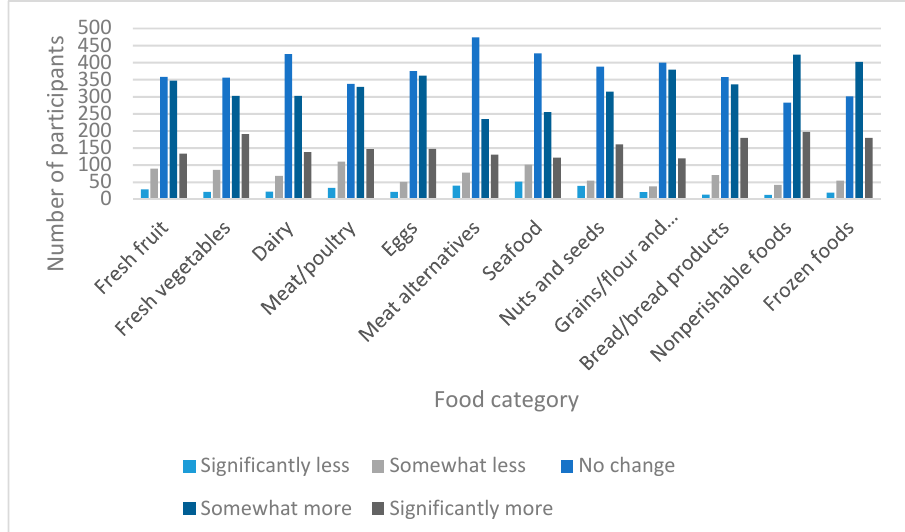
Figure 6 . Changes in grocery shopping behaviors during the COVID-19 pandemic . Figure 6. Changes in grocery shopping behaviors during the COVID-19